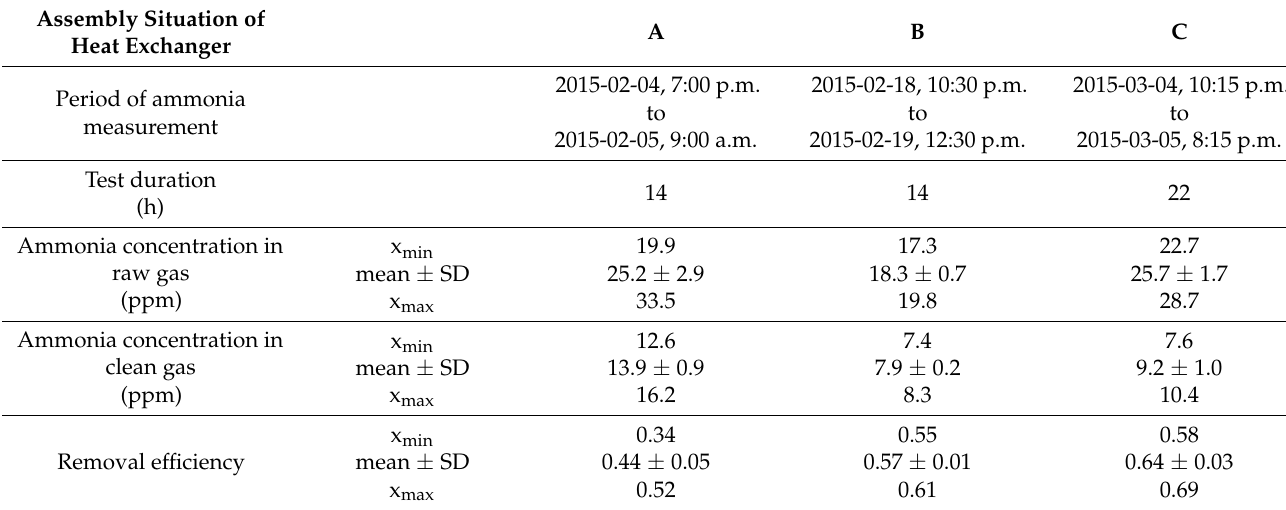
Table 2. Ammonia concentrations in raw gas and clean gas of the exchange scrubber pilot plant under field conditions as well as the ammonia removal efficiency for all three tested assembly situations of the heat exchanger ( A – C ), based on hourly